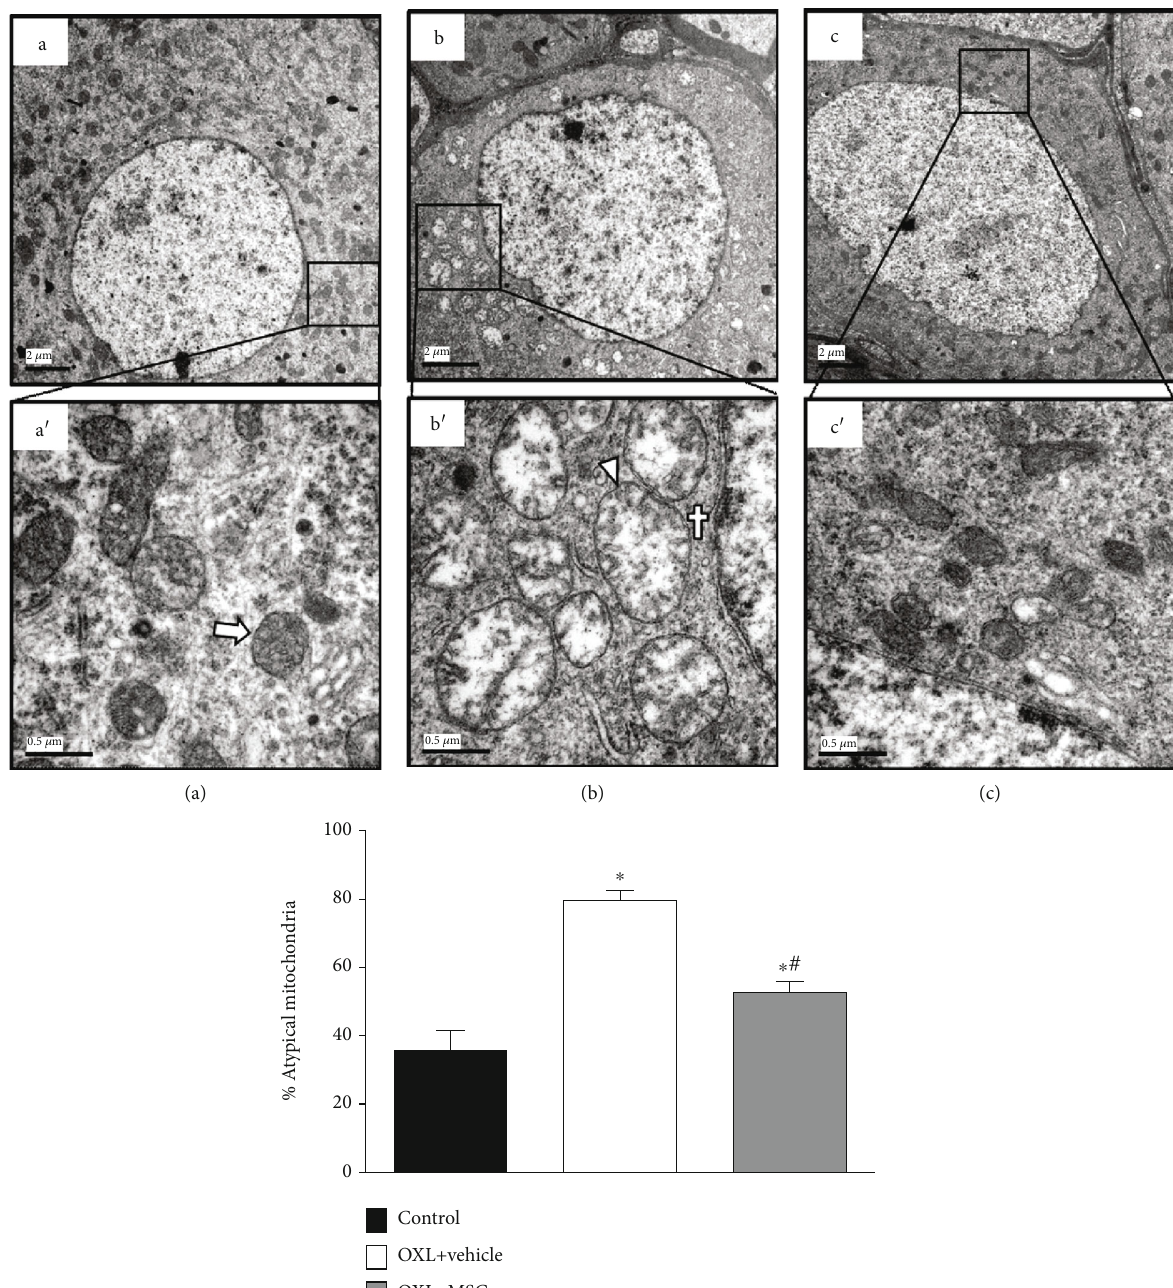
Figure 3: E ff ect of MSC on mitochondrial morphology and morphometry of dorsal root ganglia neurons of mice with OXL-induced chronic neuropathy. Electron micrographs representing dorsal root ganglia (DRG) cross-sections from nonneuropathic mice (A, D) (control group) and neuropathic mice treated with vehicle (B, E) (OXL+vehicle) or with 1 × 10 6 MSC (C, F) (OXL+MSC). Analyses were performed 4 weeks after treatments. (A) Electron micrograph of the control group with numerous typical mitochondria. (D) Higher magni fi cation (50,000x) of the highlighted area in (A), showing typical mitochondria, with intact membrane and mitochondria cristae (arrow). (B) Neuropathic mice treated with vehicle presented numerous atypical mitochondria. (E) Higher magni fi cation image showing atypical mitochondria, characterized by increased organelle area (arrowhead) and accumulation of electron-dense amorphous material on mitochondrial poles (cross). MSC-treated neuropathic mice (C, F) presented fewer mitochondrial atypia relative to vehicle-treated neuropathic mice. Scale bar = 2 μ m (A – C) (10,000x magni fi cation) and 0.5 μ m (D – F) (50,000x magni fi cation). (G) shows the percentage of atypical mitochondria found in DRG. Data are expressed as means ± standard deviation ; n = 6 mice per group. ∗ Statistical signi fi cance relative to the control group ( p < 0 : 001 ); # statistical signi fi cance relative to the OXL+vehicle group ( p < 0 : 05 ), as determined by one-way ANOVA followed by Tukey ’ s multiple comparison